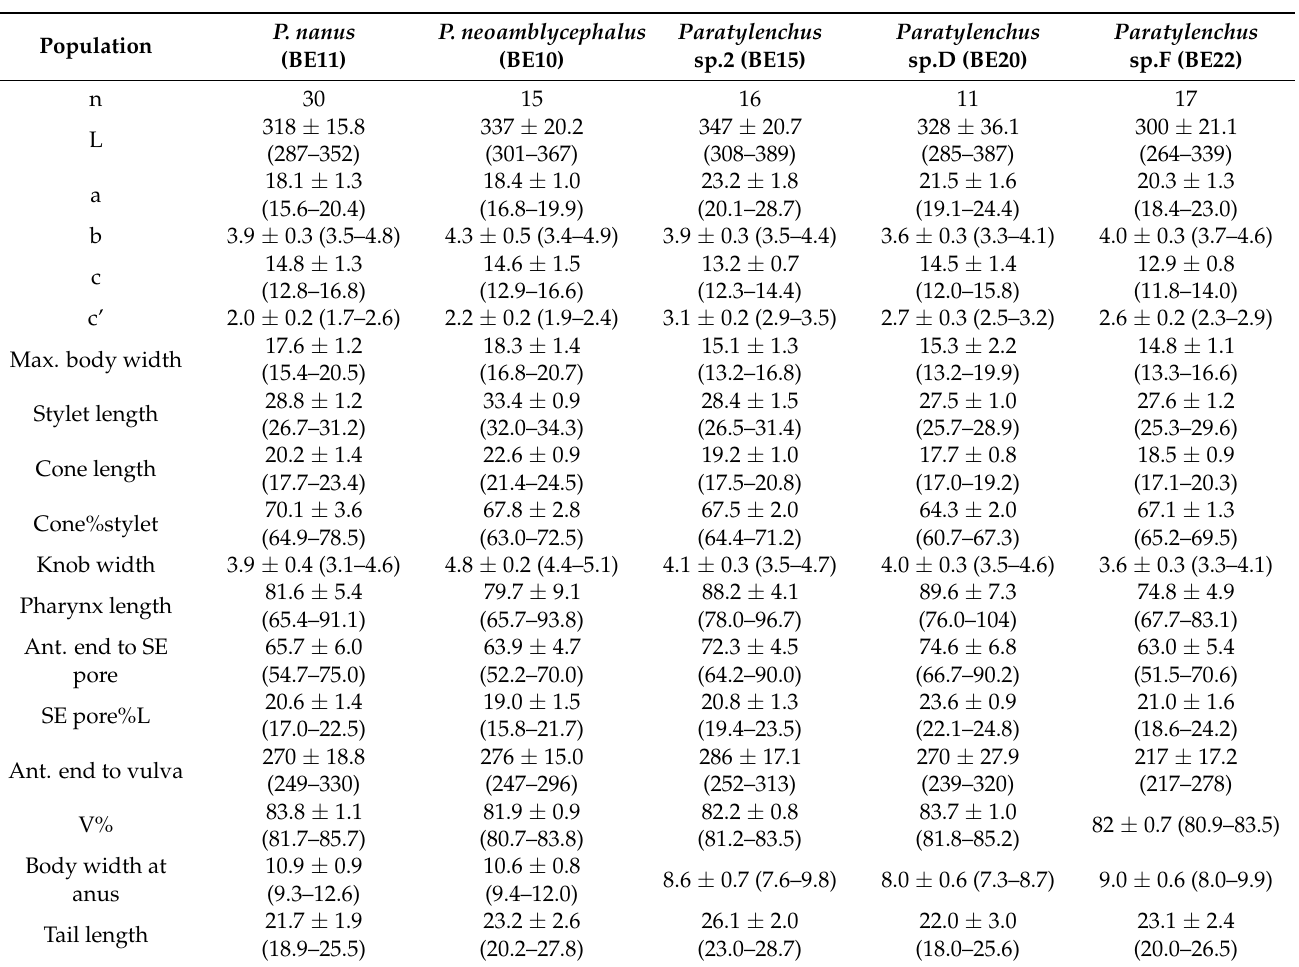
Table 4. Female morphometrics of Paratylenchus nanus , Paratylenchus neoamblycephalus , Paratylenchus sp.2, Paratylenchus sp.D and Paratylenchus sp.F from fixed specimens mounted in glycerine. All measurements except for ratios and percentages are given in µ m and in the form mean ± stdev